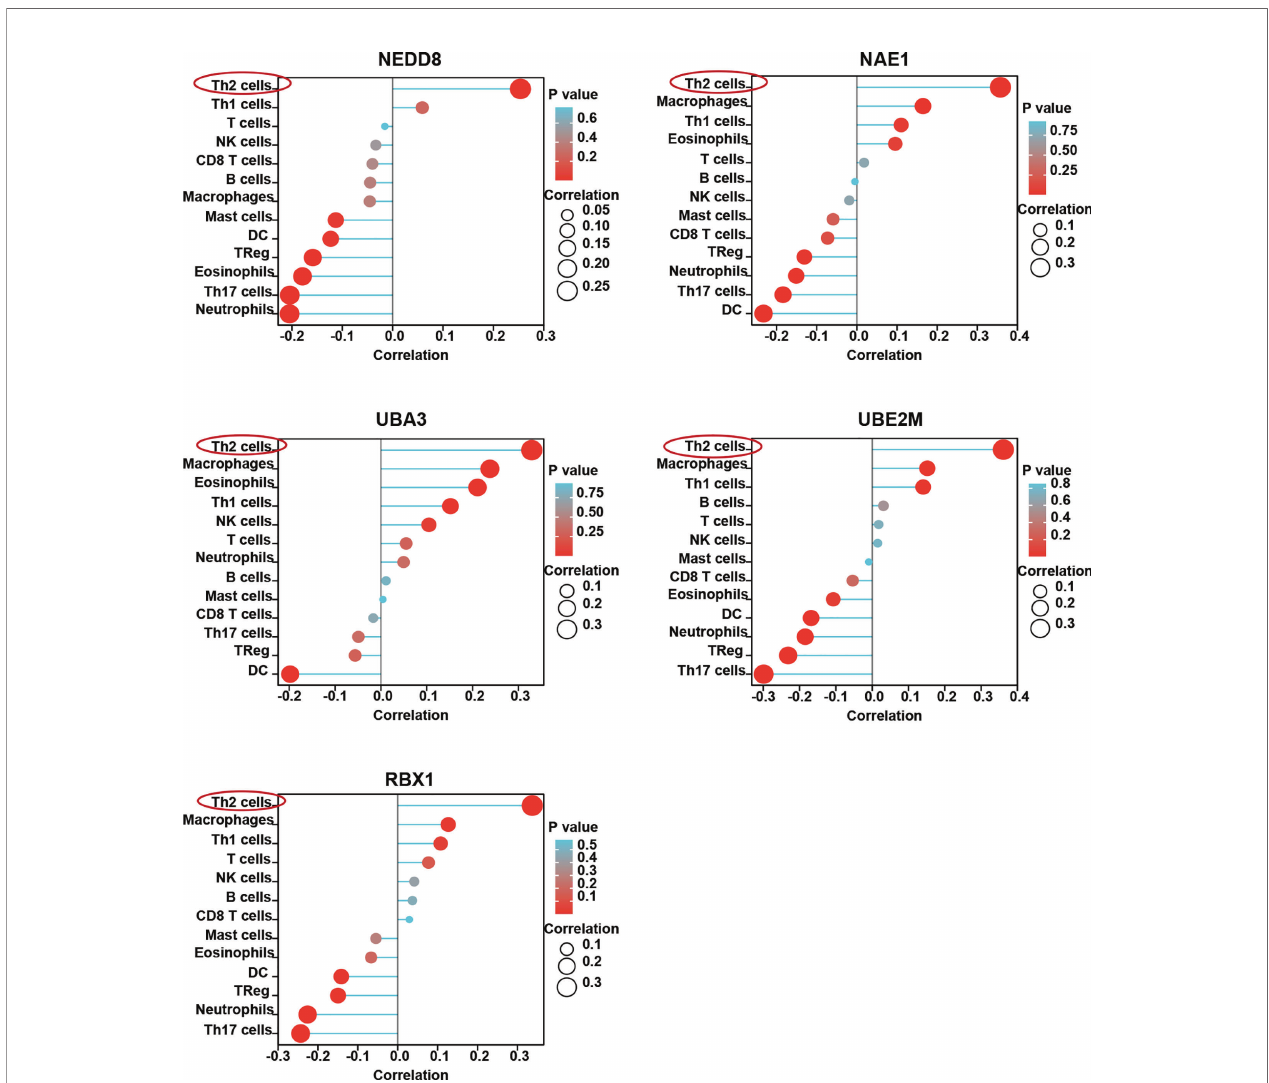
FIGURE 2 | Neddylation pathway is closely related with immune cells in fi ltration in HCC. ssGSEA was used to evaluate the correlation of neddylation pathway and 13 immune in fi ltration cells in